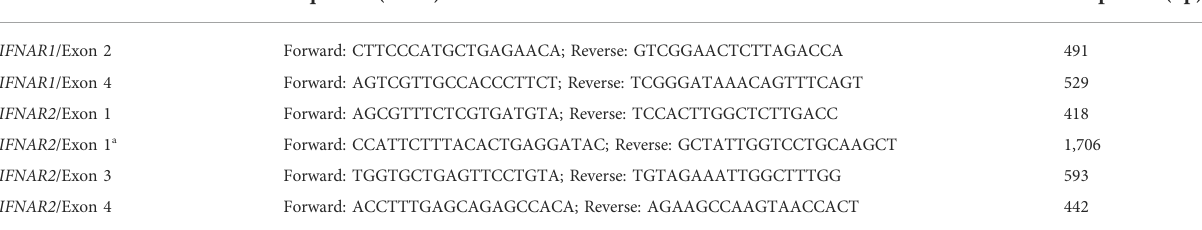
TABLE 1 PCR primers for the ampli fi cation of IFNAR1 and IFNAR2